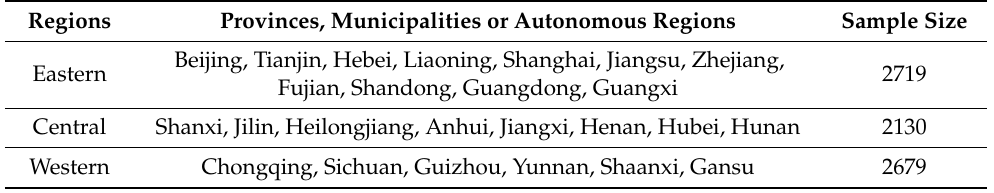
Table 2. The eastern, central and western regions. Regions Provinces, Municipalities or Autonomous Regions Sample Size Eastern